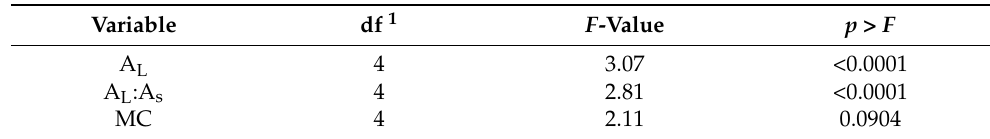
1 Means associated with different lowercase letters are significantly different at an α -level of 0.05 and 0.10 for A L :A S and MC, respectively, by the Tukey HSD test for multiple comparisons.